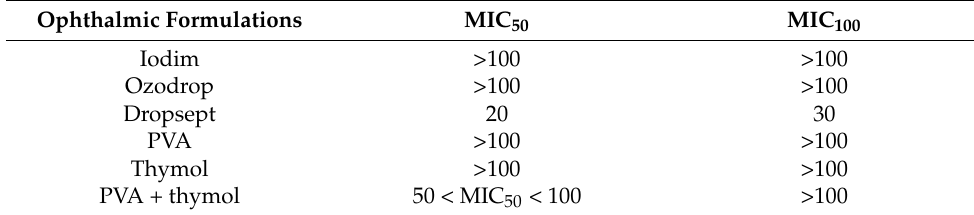
Table 4. E. coli MIC 50 and MIC 100 .